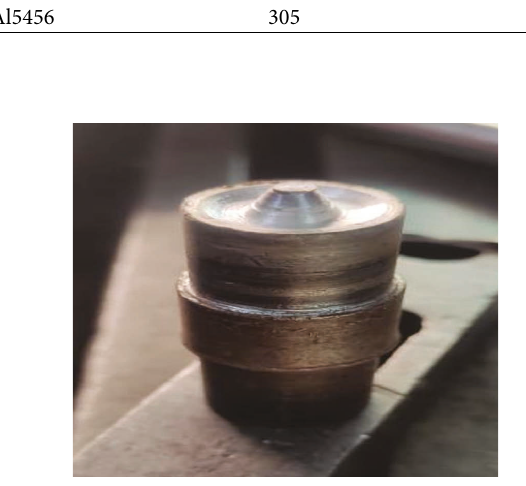
Figure 1: FSW HSS-13 tool. Table 3: FSW process parameter